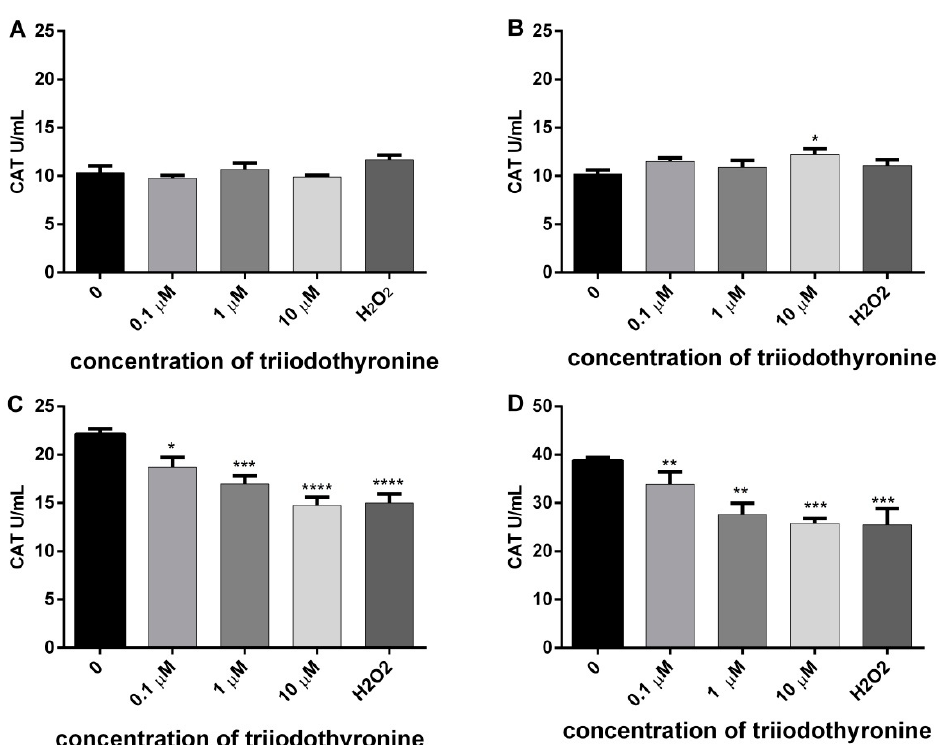
Figure 2. Activity of catalase (CAT) in lymphocytes of ( A ) normal, ( B ) obese, ( C ) prediabetics, and ( D ) DMT2 persons treated with vireos concentrations of triiodothyronine and (T 3 ) positive control (H 2 O 2 ). The results are presented as means ± standard error of mean (SEM). * p < 0.05, ** p < 0.01; *** p < 0.001; **** p < 0.0001 in comparison to the negative control, in one-way ANOVA by Dunnett test.